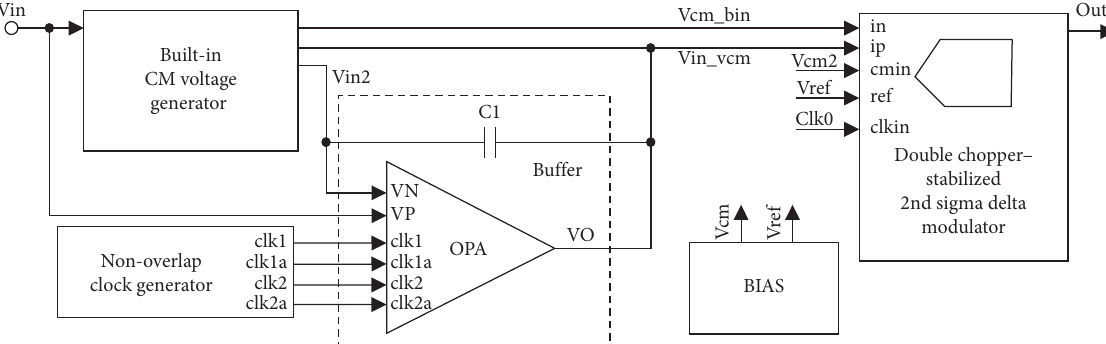
Figure 1: Transmitter diagram of optical isolation